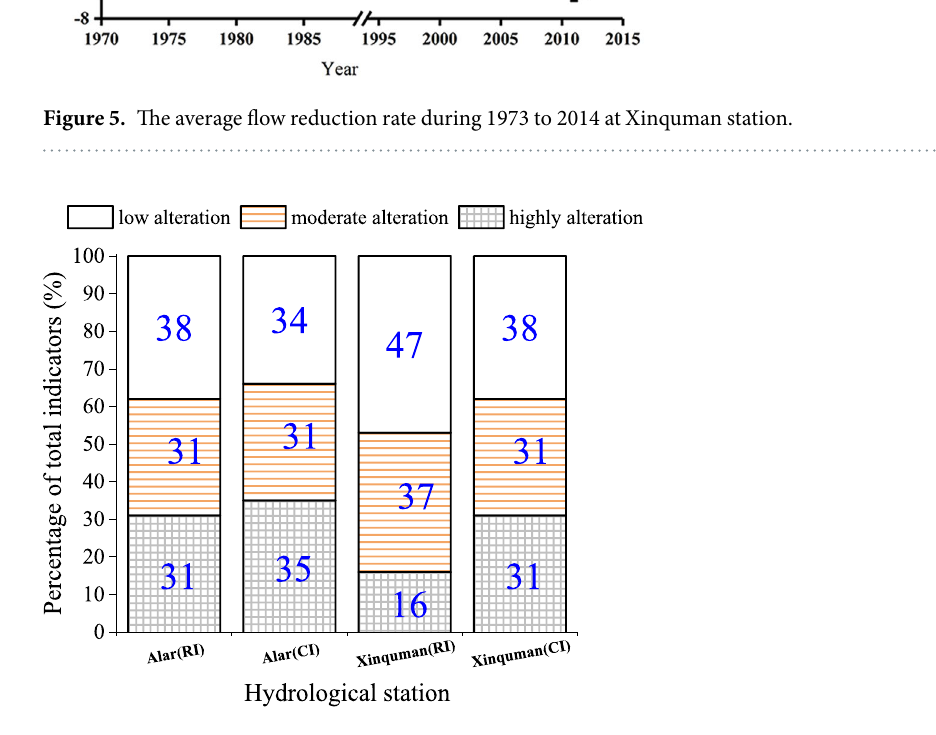
Figure 6. Bar plot of percentage of IHAs that are categorized into three ranks during the RI impacted period and the CI impacted period at the Alar and Xinquman stations.